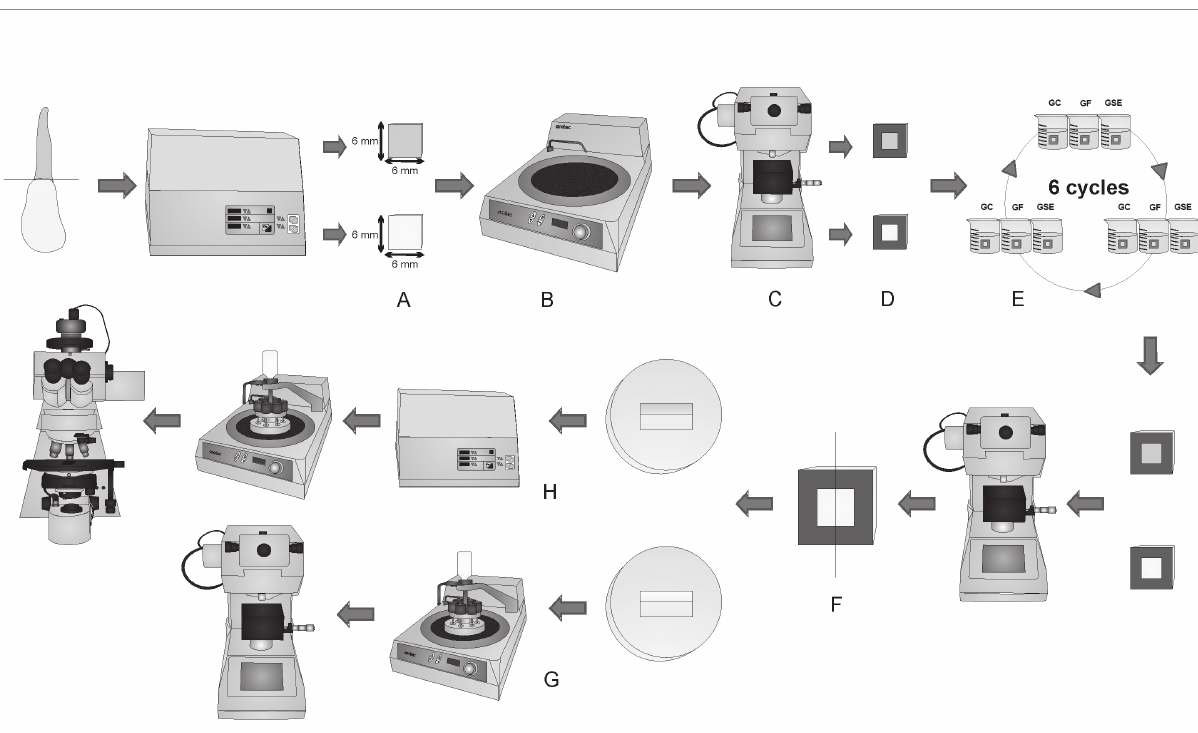
Figure 1- Schematic diagram of the methodology - (A) Obtaining fragments of enamel and dentin; (B) Polishing the specimens; (C) Measuring the initial microhardness; (D) Application of two layers of acid-resistant varnish; (E) pH cycling with treatments; (F) Sectioning the specimens; (G) Procedures for analysis of the perpendicular hardness to the demineralized surface; (H) Procedures for cross-sectional hardness analysis of the